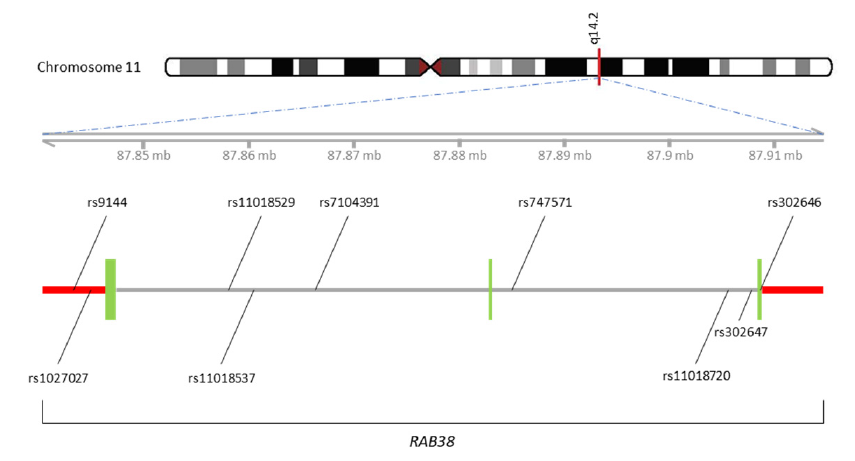
Figure 3. Illustration of genotyped human RAB38 gene polymorphisms on chromosome 11. Red bar represents untranslated regions (UTR). Green bar represents exons.